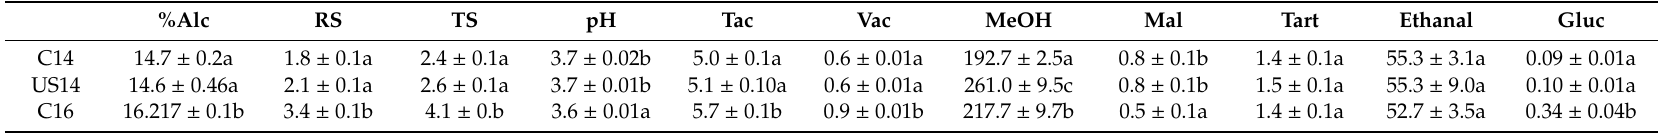
Table 1. Physico-chemical characteristics of the studied